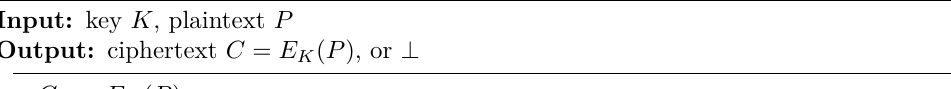
Algorithm 1 Simple time redundancy with